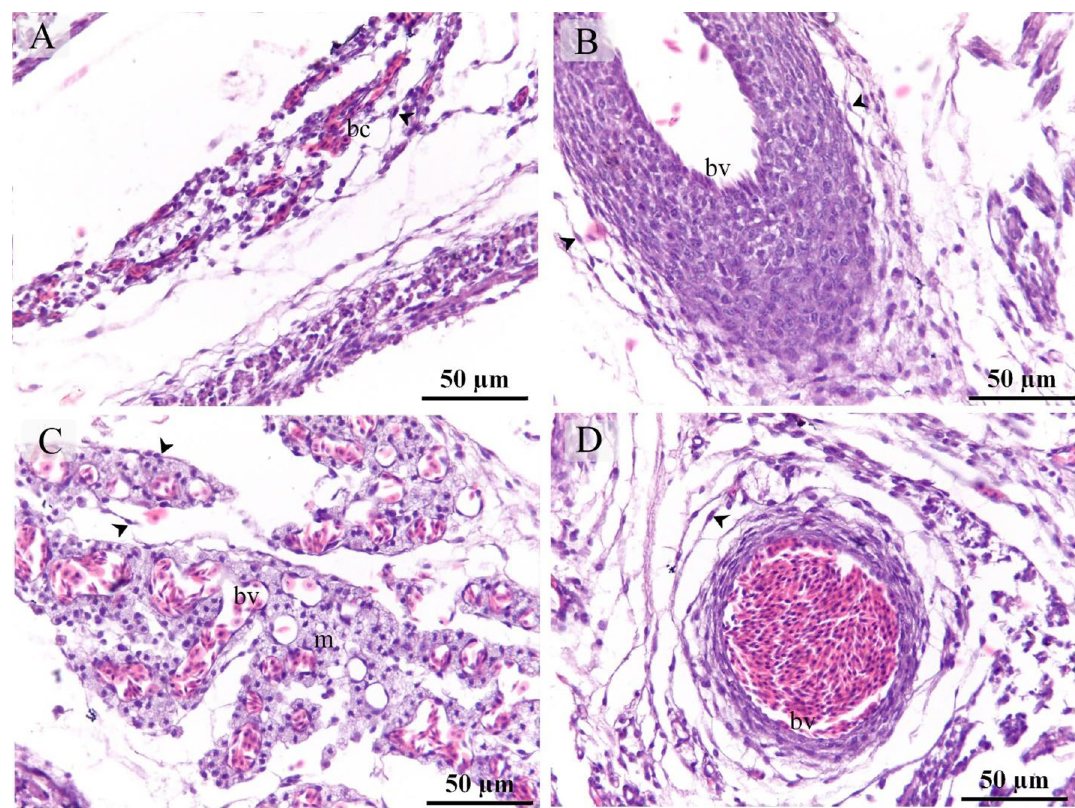
Figure 1. Recognition of perivascular TCs. Paraffin sections of the neck skin of day 8 quail embryos stained by H&E. ( A ) TC (arrowhead) was located around the blood capillary (bc). ( B , D ): TCs (arrowheads) were located around the blood vessels (bv). ( C ): TCs (arrowheads) were closely related to the vascular plexus. Note that the macrophage (m) had a vacuolated